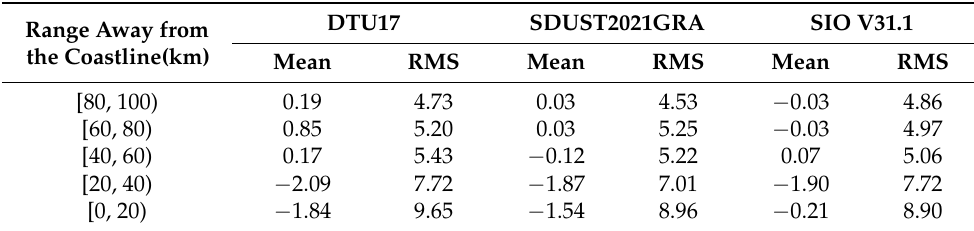
Table 4. The difference between the global model and shipboard gravity in different ranges from the coastline (Unit: mGal). Range Away